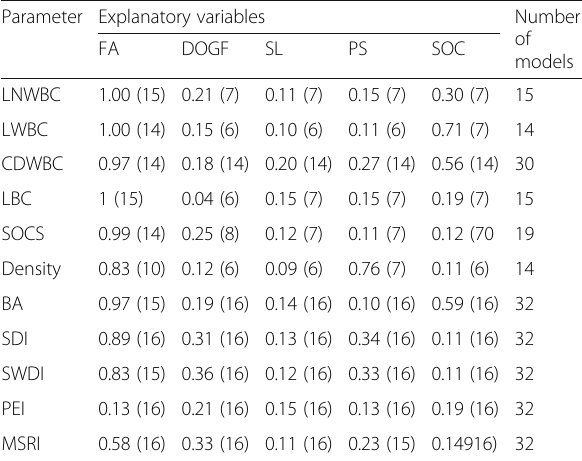
Table 4 The relative importance of the site environmental attributes in the final linear mixed effect models (LMEM) Parameter Explanatory variables Number